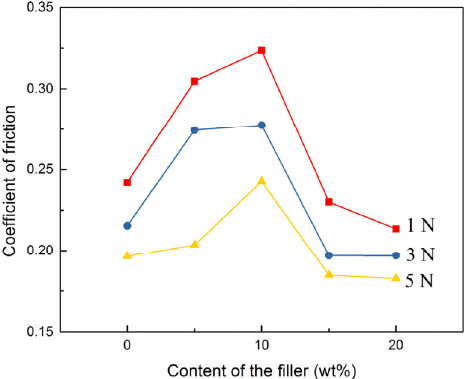
Fig. 33 The mean friction coefficient as a function of BP content under different loads.